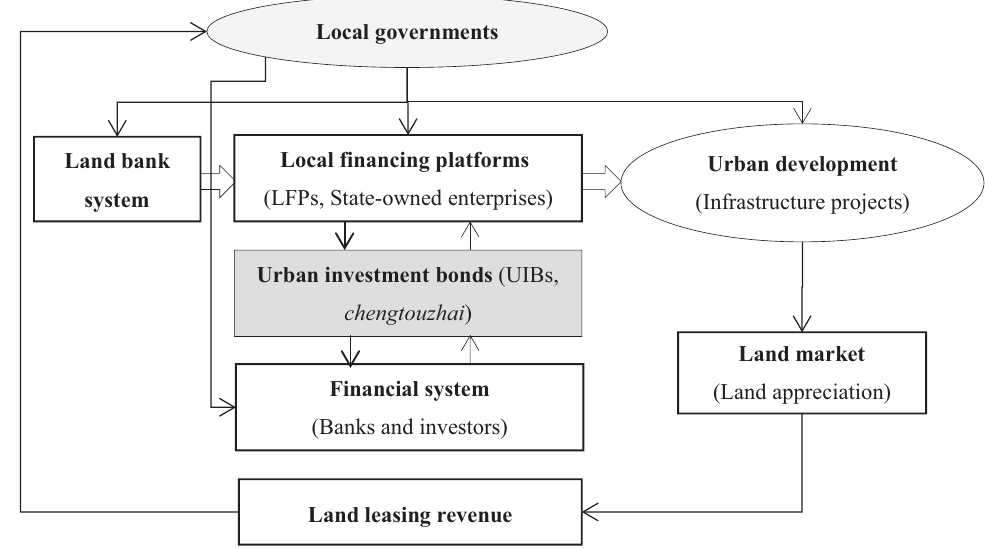
Figure 1. China’s UIBs issuance and repayment